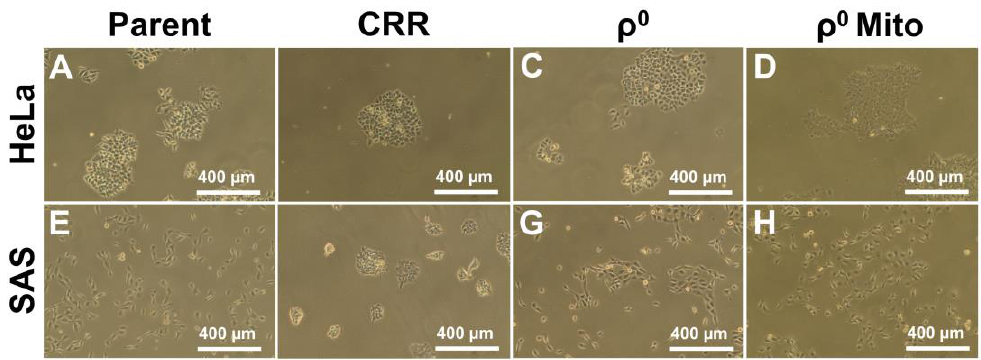
Figure 2. Morphology of CRR cells, ρ 0 cells, ρ 0 cells harboring transferred mitochondria, and parental cells. ( A ): HeLa parent cells, ( B ): HeLa CRR cells, ( C ) : HeLa ρ 0 cells, ( D ) : HeLa ρ 0 Mito cells, ( E ): SAS parent cells, ( F ): SAS CRR cells, ( G ): SAS ρ 0 cells, ( H ): SAS ρ 0 Mito cells. Table 2. Characteristics of clinically relevant radioresistant (CRR) cells.